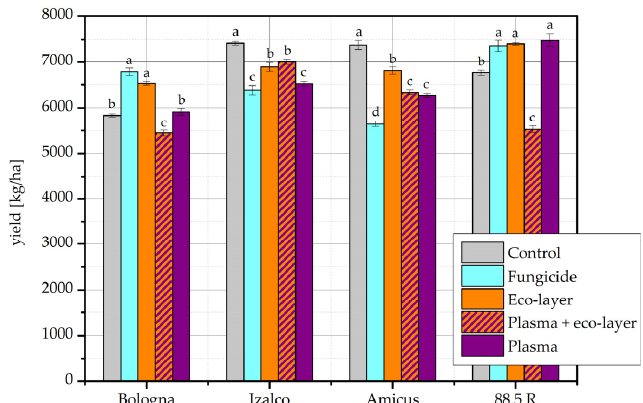
Figure 5. Yield results (kg/ha) of the field experiment according to individual treatments and culti- vars of wheat in the year 2020/21. The error bars represent standard error. Different lowercase letters above data points represent statistically significant differences ( p < 0.05; post hoc Tukey’s range test) between treatments.